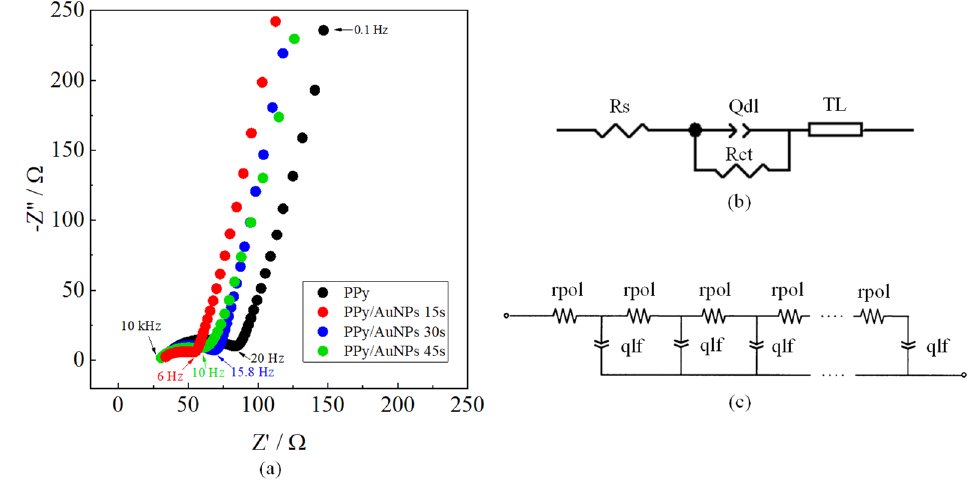
Figure 6. ( a ) Nyquist diagrams of PPy, PPy/AuNPs 15 s, PPy/AuNPs 30 s, and PPy/AuNPs 45 s in PBS containing 5 mmol L − 1 of AA at a dc potential of 0.4 V. ( b ) Equivalent circuit used to fit EIS data, and ( c ) the transmission line (TL) model is presented in the equivalent circuit.